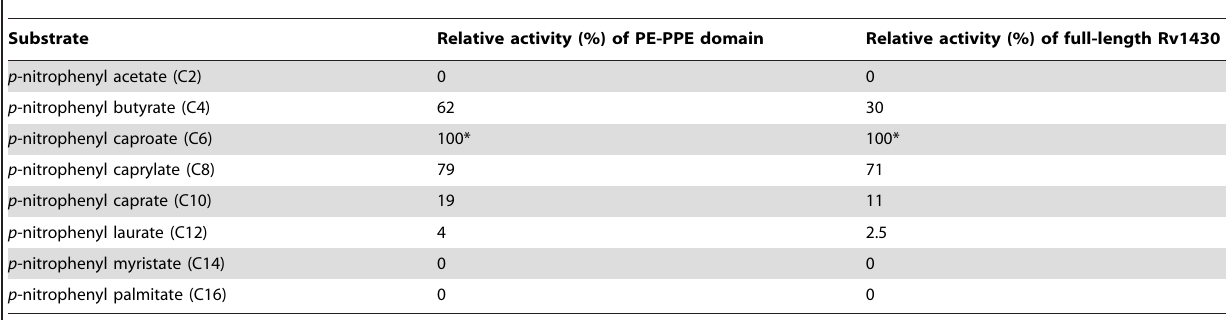
Table 1. Relative enzyme activity of Rv1430 and PE-PPE domain towards p -nitrophenyl derivatives at pH 7.0 and 37 u C.